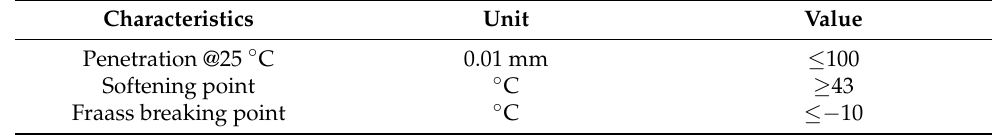
Table 2. Characteristics of bitumen contained in the emulsion (data provided by the supplier).